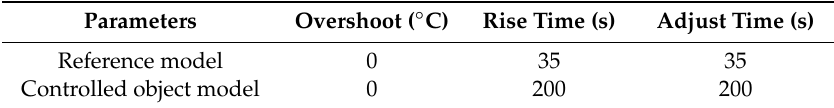
Table 13. Comparison of parameters of models.